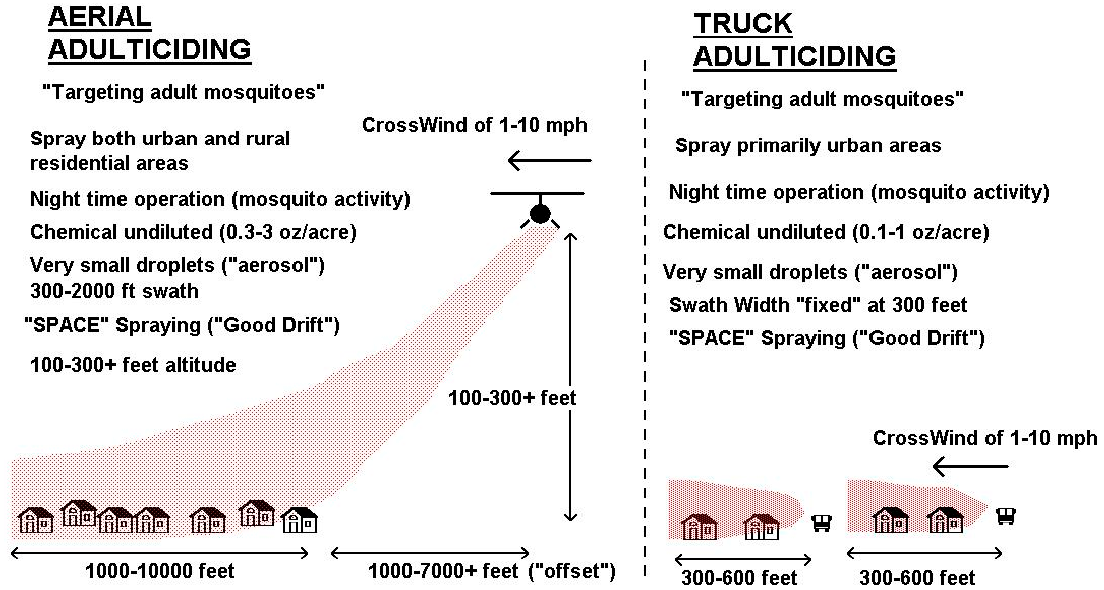
Figure 3. Criteria for successful aerial and vehicle ULV adulticiding (Courtesy of Mark D. Latham).